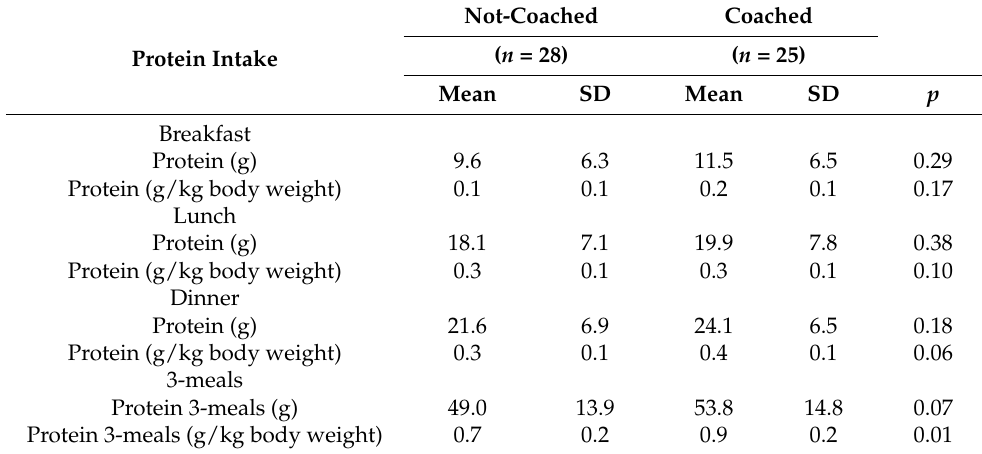
Table 2. Protein Intakes of Participants at Meals at